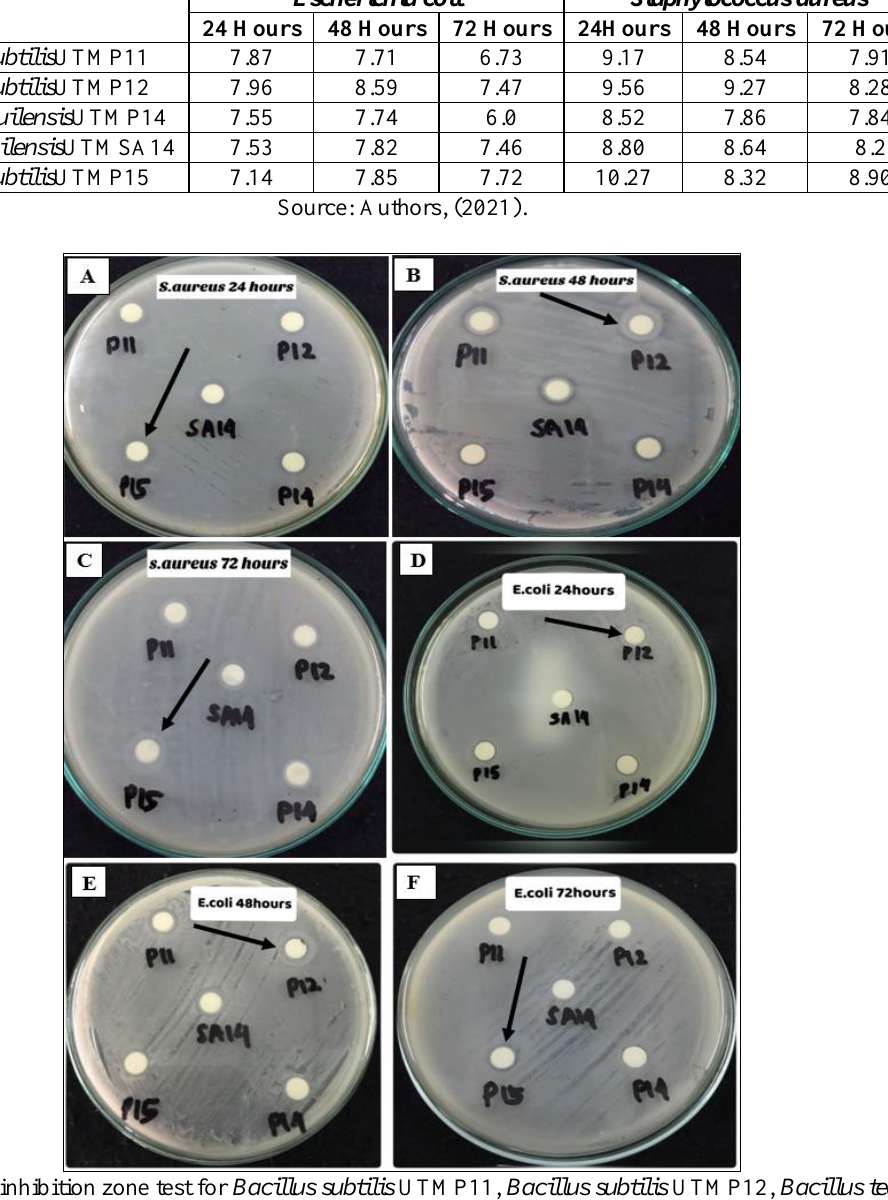
Table 3: Zone of inhibition results for the thermophilic bacteria isolates against pathogenic bacteria (disk diameter = 6mm). No.